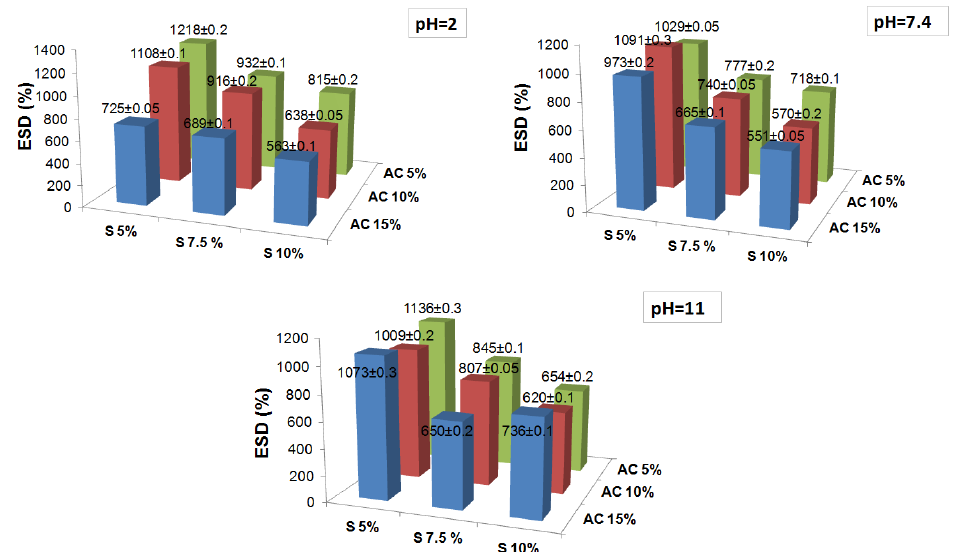
Figure 2. The influence of reactants concentration on the equilibrium swelling degree at different pH values of the obtained crosslinked salecan samples. The results are the average values with added standard errors.